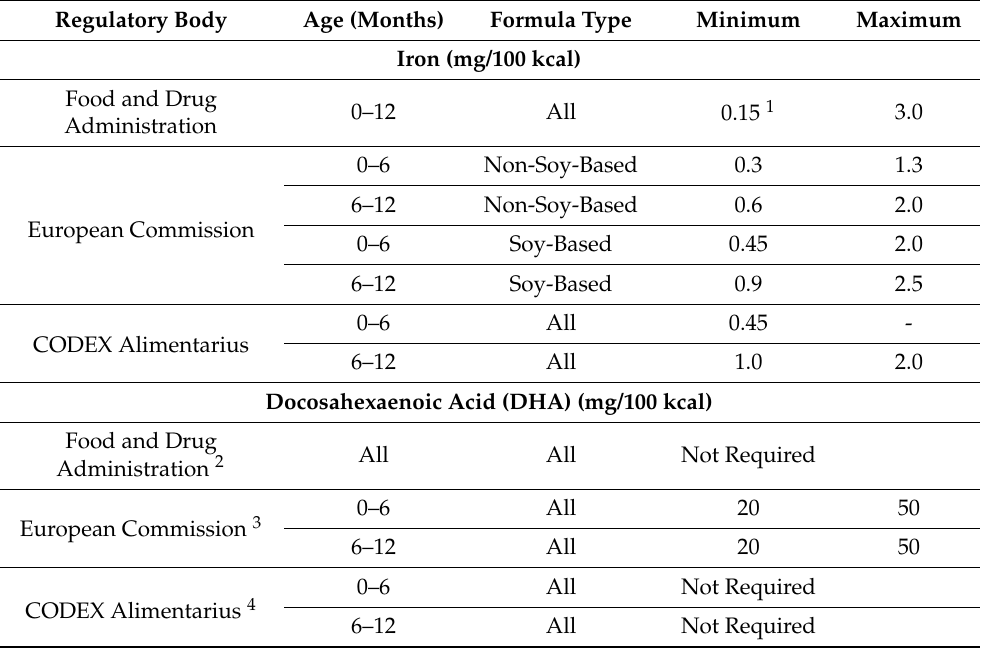
Table 1. International regulatory bodies requirements for iron and DHA in infant formula. Regulatory